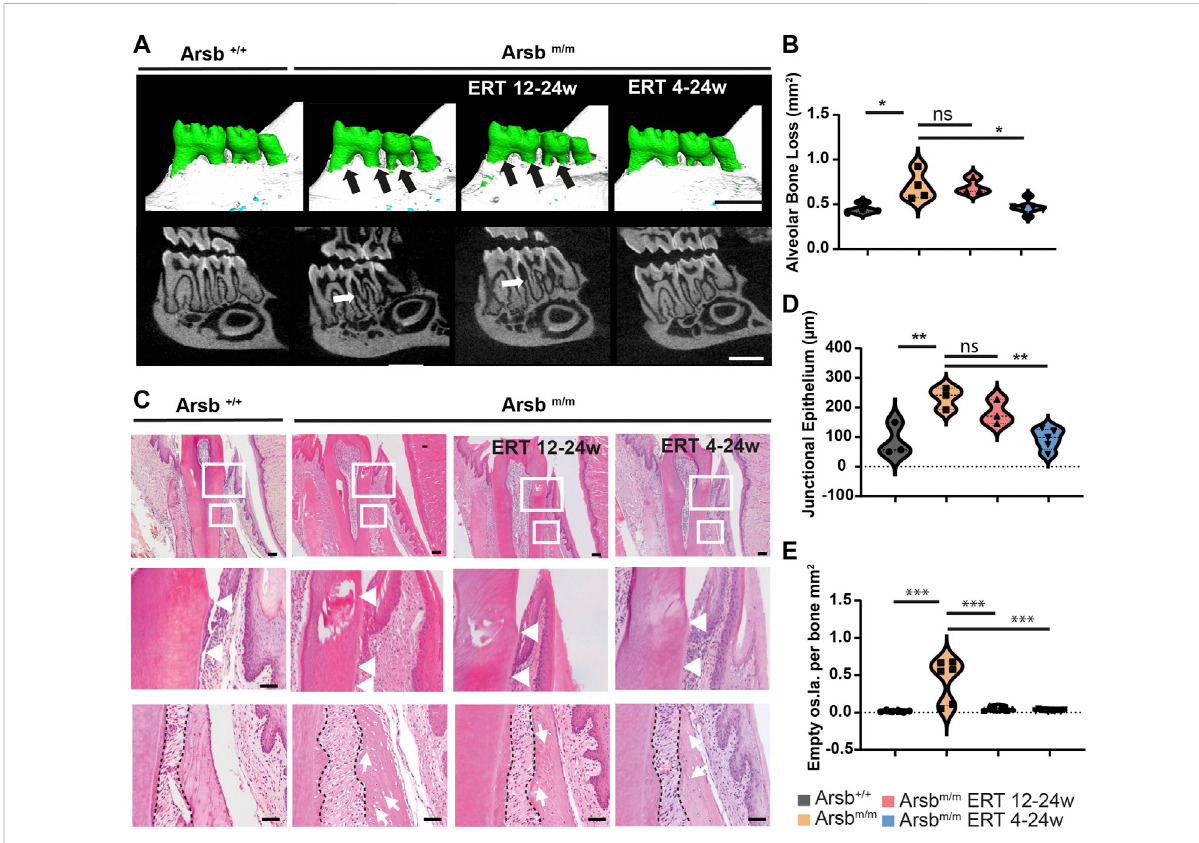
Severe alveolar bone loss and reduced junctional epithelium growth in Arsb m/m and late-start ERT Arsb m/m mice. (A) 3D reconstructions based on μ CT scans of the mandibular molars (upper panel). Arsb m/m -mice and late-start ERT Arsb m/m -mice showing severe alveolar bone loss exposing roots and branches (black arrows). In contrast, control and Arsb m/m mice with early start ERT 4-24w show physiological bone levels. Lower panel: μ CT cross-sectional view showing low proximal bone level in Arsb m/m mice and Arsb m/m mice with ERT 12-24 w (white arrows). Scale bar = 1 mm. (B) Quanti fi cation of alveolar bone loss in control, Arsb m/m and early- and late start of ERT Arsb m/m mice. (C) Decalci fi ed tooth sections stained with hematoxylin and eosin. Higher magni fi cation images of the areas marked by white rectangles representing the junctional epithelium, periodontium, and alveolar bone. The images in the middle panel show apical downward growth of the junctional epithelium in Arsb m/m mice, with the cementoenamel junction and the apical end of the junctional epithelium marked with white arrows. In Arsb m/m mice with ERT 12-24w and ERT 4-24w, the downward growth was less pronounced. Lower panel: All Arsb m/m mice with and without ERT, showed dispersion of the periodontal ligament and hypertrophic osteocytes in the alveolar bone (white arrows). Scale bar = 100 µm. (D) Quanti fi cation of downward growth of the junctional epithelium. (E) Quanti fi cation of apparent empty osteocyte gaps per bone of the indicated control and Arsb m/m mice. * p < 0.05. ** p < 0.01. *** p <